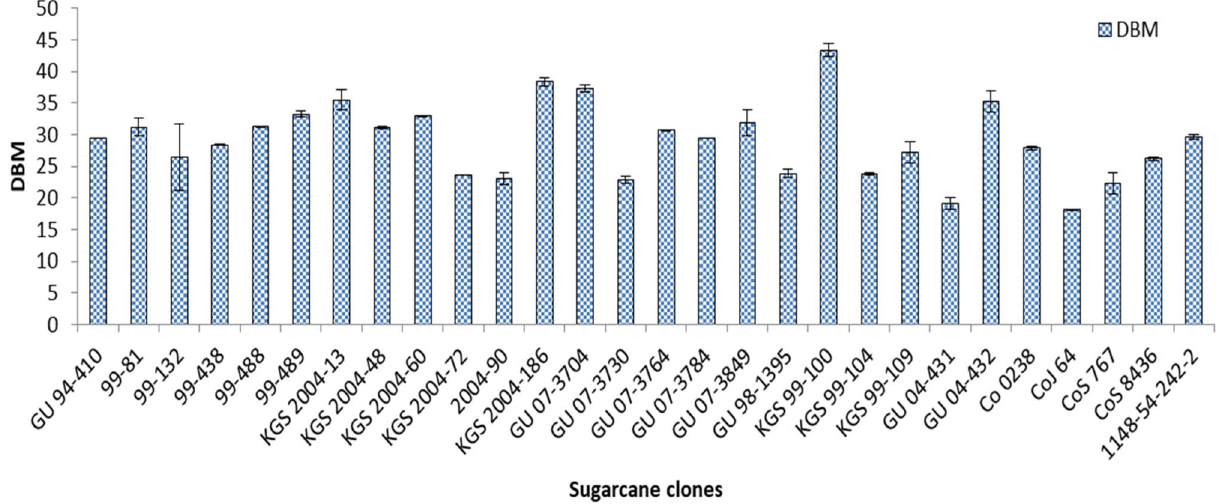
Figure 1. Dry biomass potential (DBM (t/ha)) of interspecific (ISH), intergeneric (IGH), and commercial hybrids of